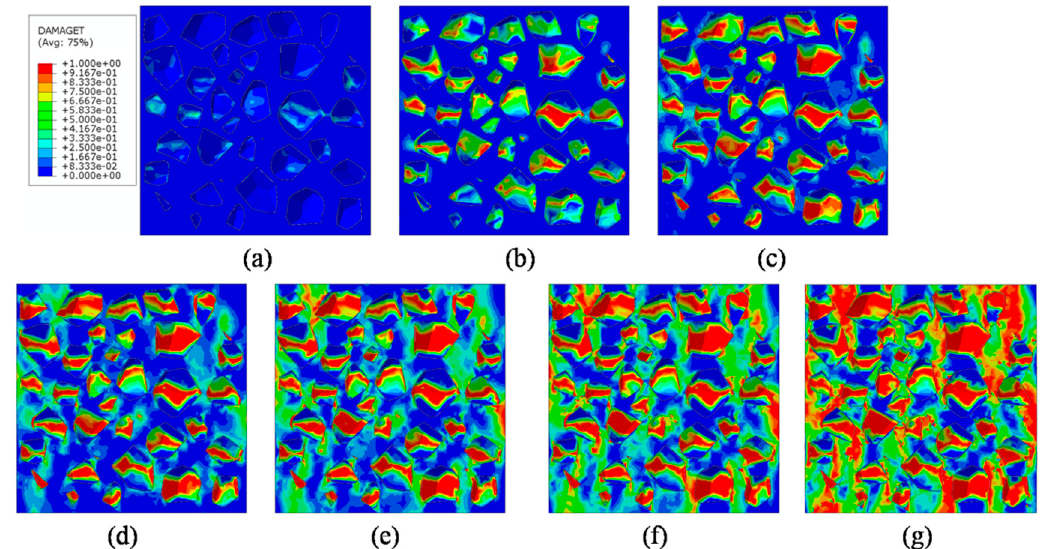
Figure 30. Section patterns of tensile damage initiation and evolution under compression.